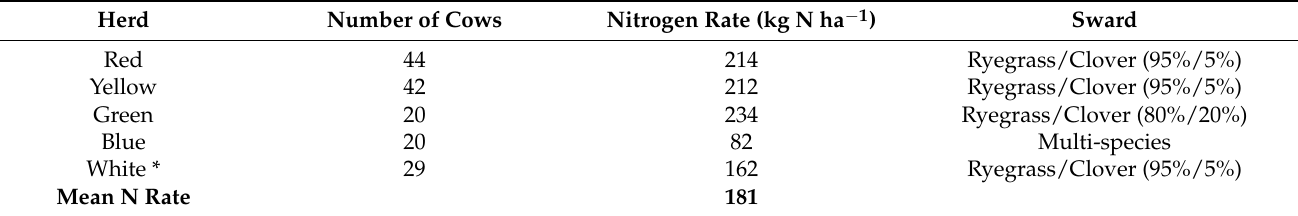
Table 4. Description of the individual dairy cow herds and